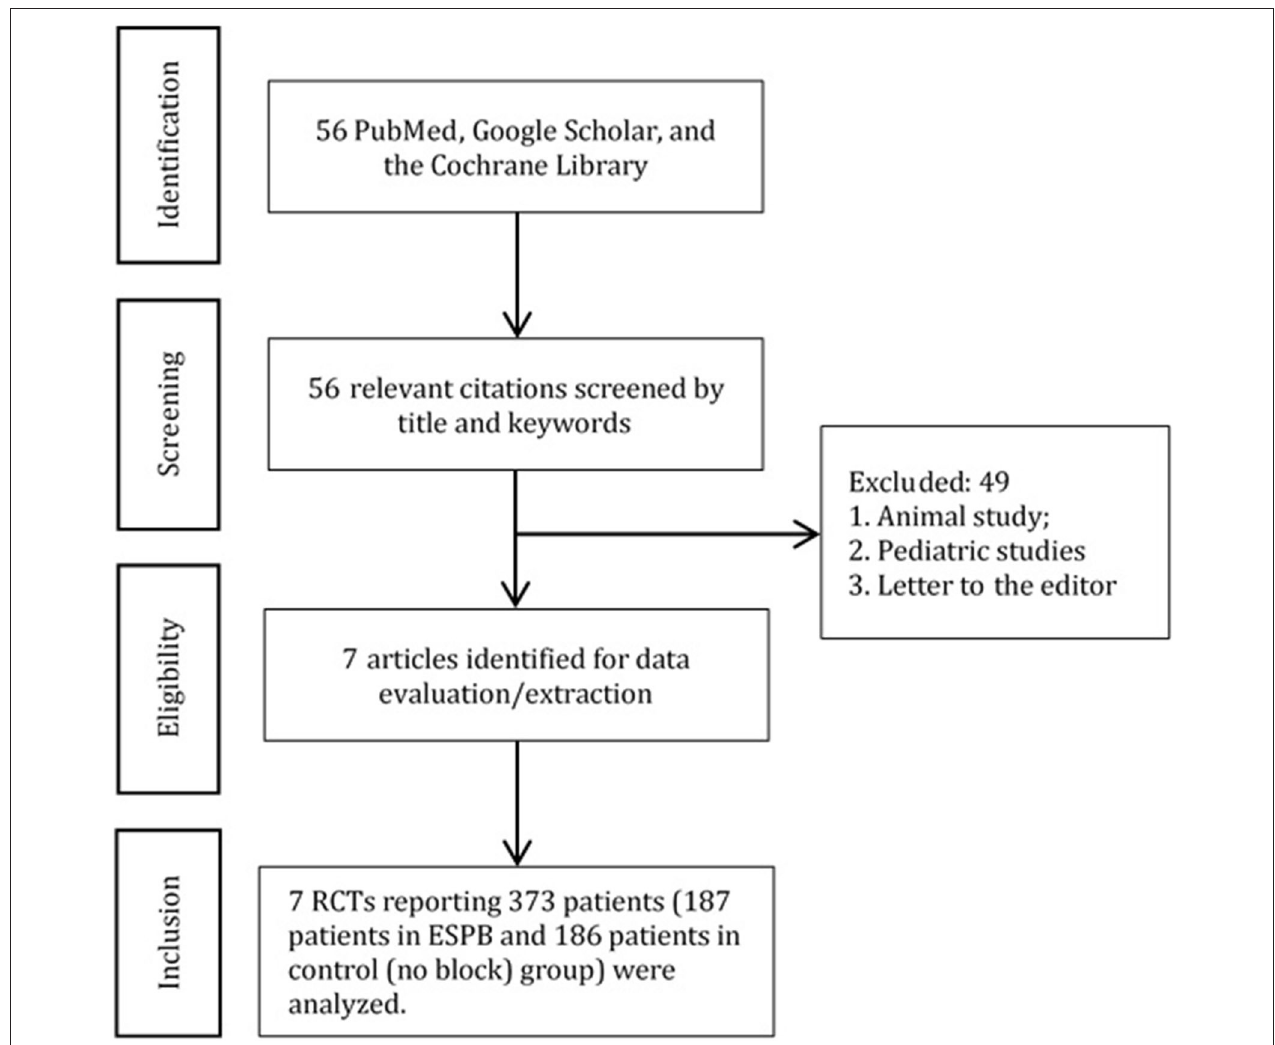
FIGURE 1 | PRISMA